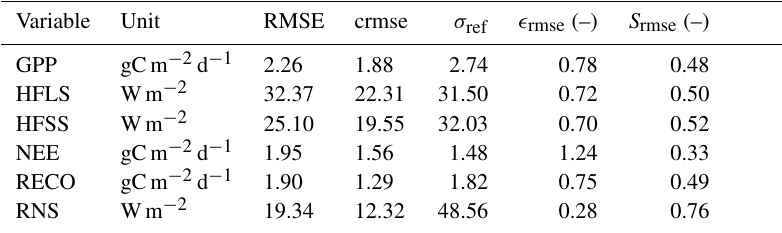
Table A2. Site-level statistical metrics for calculating S rmse at the 31 FLUXNET sites. “crmse” is the “centralized RMSE”, which is the RMSE of the anomalies. This ensures that the RMSE score excludes also considering the bias, which is captured by the bias score. Variable Unit RMSE